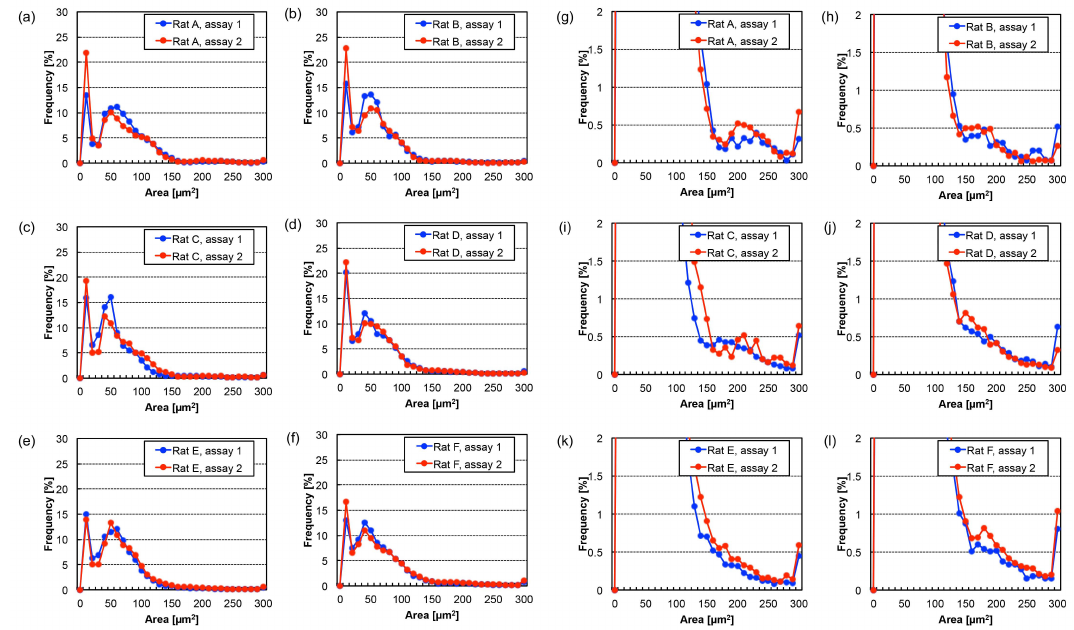
Figure 5. Size distribution of BF cell areas in positive blood from six individual rats 11 days after cancer cell implantation. ( a – f ) indicate the results for six rats with overlaps of assays performed twice using the same blood samples, to confirm the reproducibility of the measurements; ( g – l ) are magnified versions of ( a – f ) to emphasize the frequency values in large cell areas (e.g., ( g ) is a magnified version of ( a